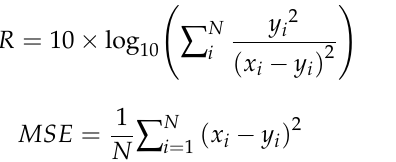
Table 4. Comparison of noise reduction effects for different SNR cases.